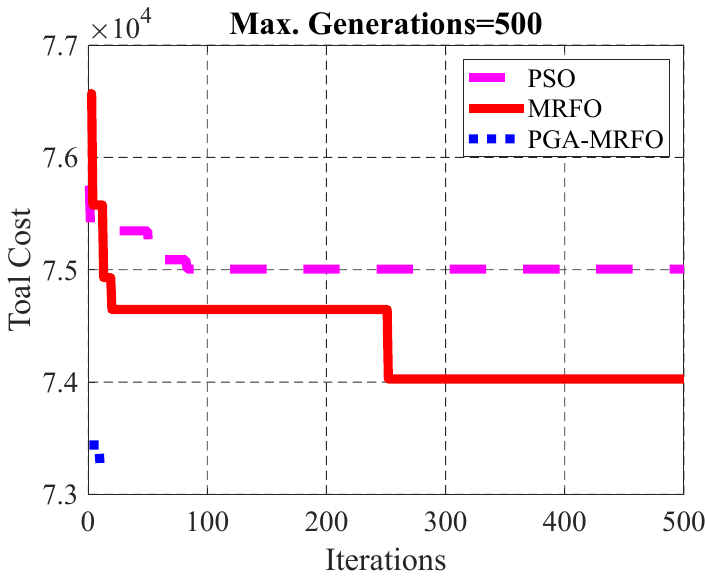
Figure 16. Converges curves for UC problem—Case 1 at max. Generations = 500.